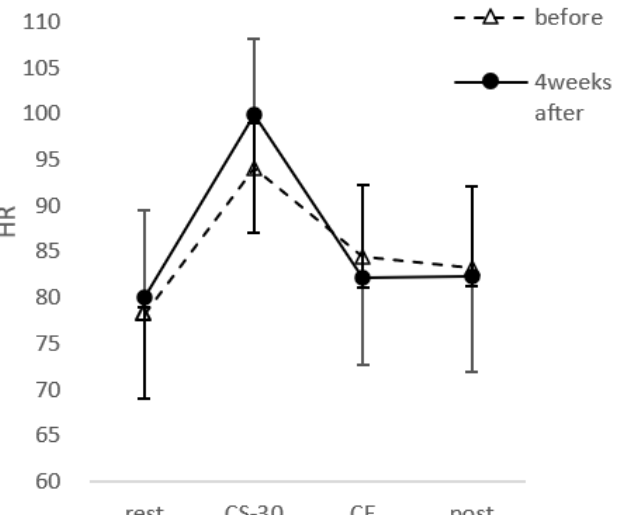
Figure 8. Heart rate across each point for before and after the 4-week PX supplementation period. Data were analyzed using two-way ANOVA. HR: heart rate, rest: before exercise, CS-30; immedi- ately after CS-30 exercise, CE: during Co-kara exercise, post; after Co-kara exercise. CE was meas- ured using the wearable activity monitor. There was a main effect of time ( p < 0.01) and an interac- tion ( p < 0.01).